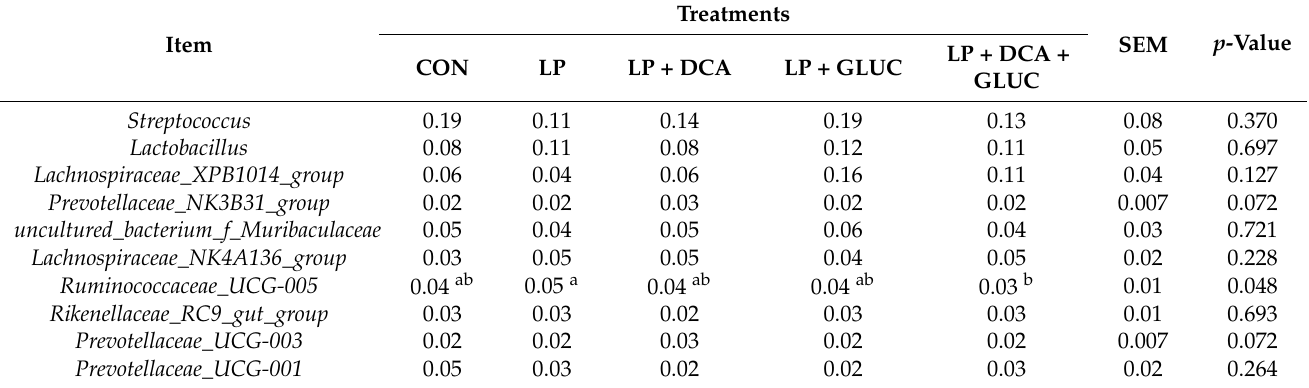
Table 5. Effects of supplementing low protein (LP) diets with sodium dichloroacetate (DCA) and glucose (GLUC) on colonic microbiota composition at genus level (Top 10) in growing-finishing